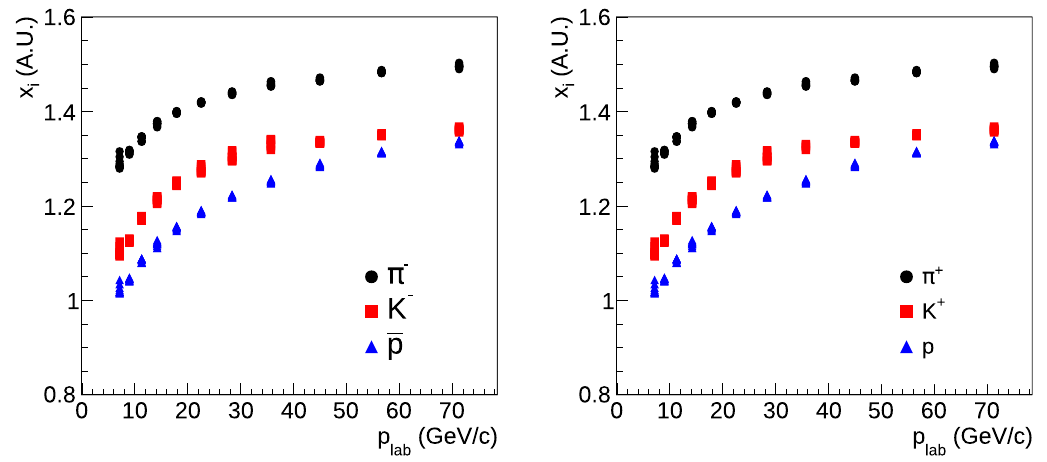
Fig. 9 Fitted peak positions in selected Be+Be interactions at 150 A GeV / c for different particles as a function of p lab . The x i for different p T at each p lab show little variation and mostly overlap